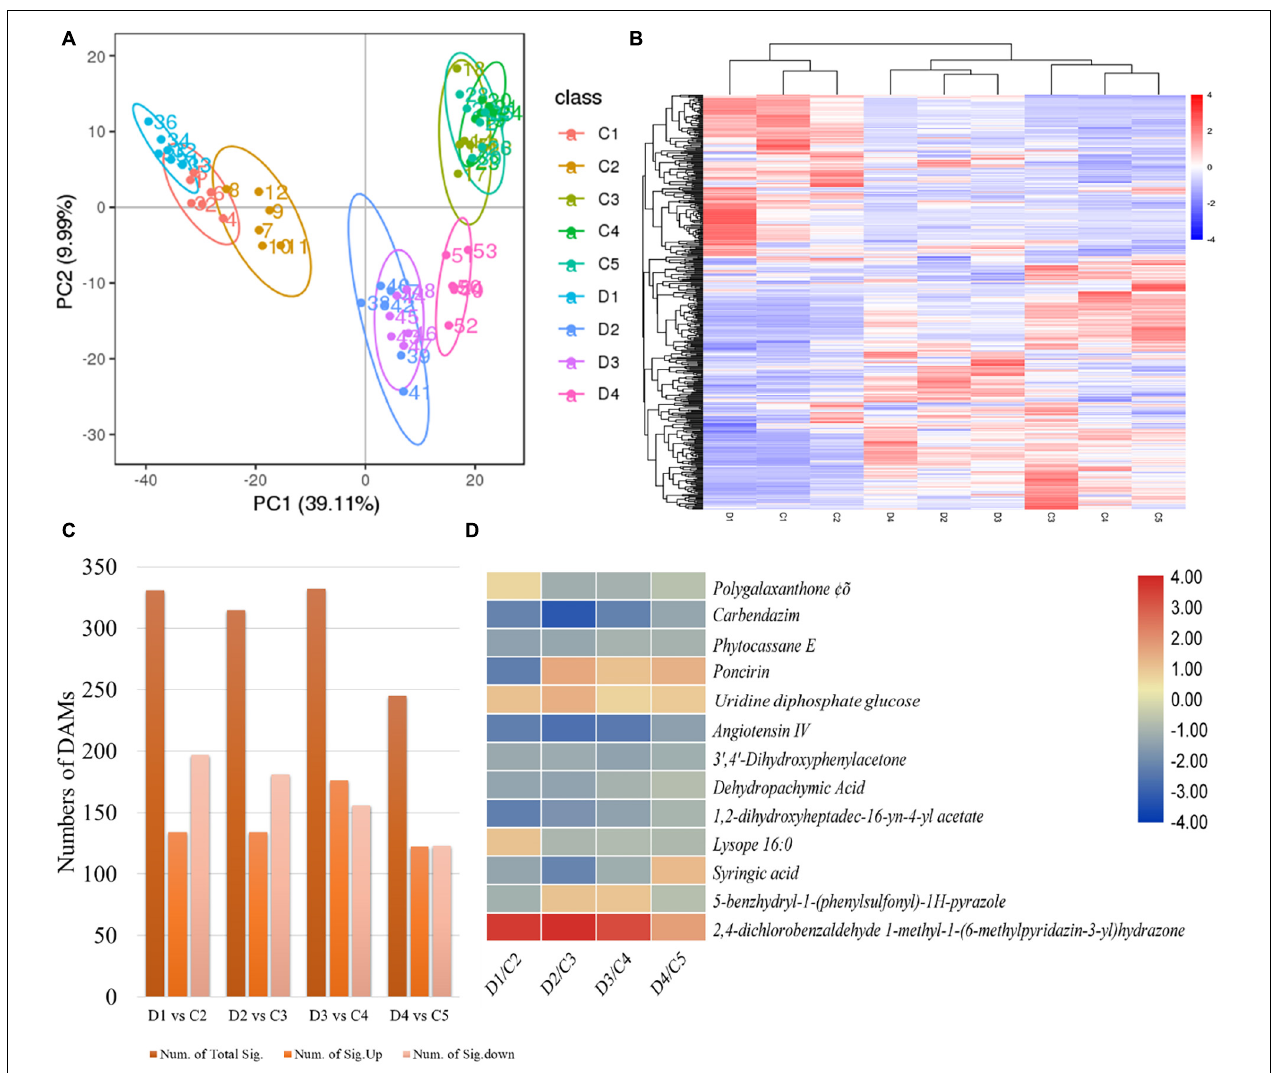
FIGURE 5 | (A) Principal component analyses, (B) heatmap of the differentially accumulated metabolites (DAMs), (C) number of DAMs in each treatment comparison, and (D) common accumulated metabolites in C (control group) and D (experiment group) of Citrus limon fruit peels. C1, C2, C3, C4, and C5 represent the samples collected 30, 60, 90, 120, and 150 days after flowering. D1, D2, D3, and D4 represent the samples collected 60, 90, 120, and 150 days after flowering. The numbers 1, 2, and 3 with each treatment represent the three replicates. The bar on the side shows the scale of metabolite intensities from lowest (blue) to highest (red). (C) Summary of metabolites detected in each treatment comparison between (C,D) . (D) Heatmap of the log2 fold change values of the commonly detected DAMs in both types of peels in all days after flowering. The scale bar on the side represents the lowest (blue) to highest (red) log2 fold change values of the